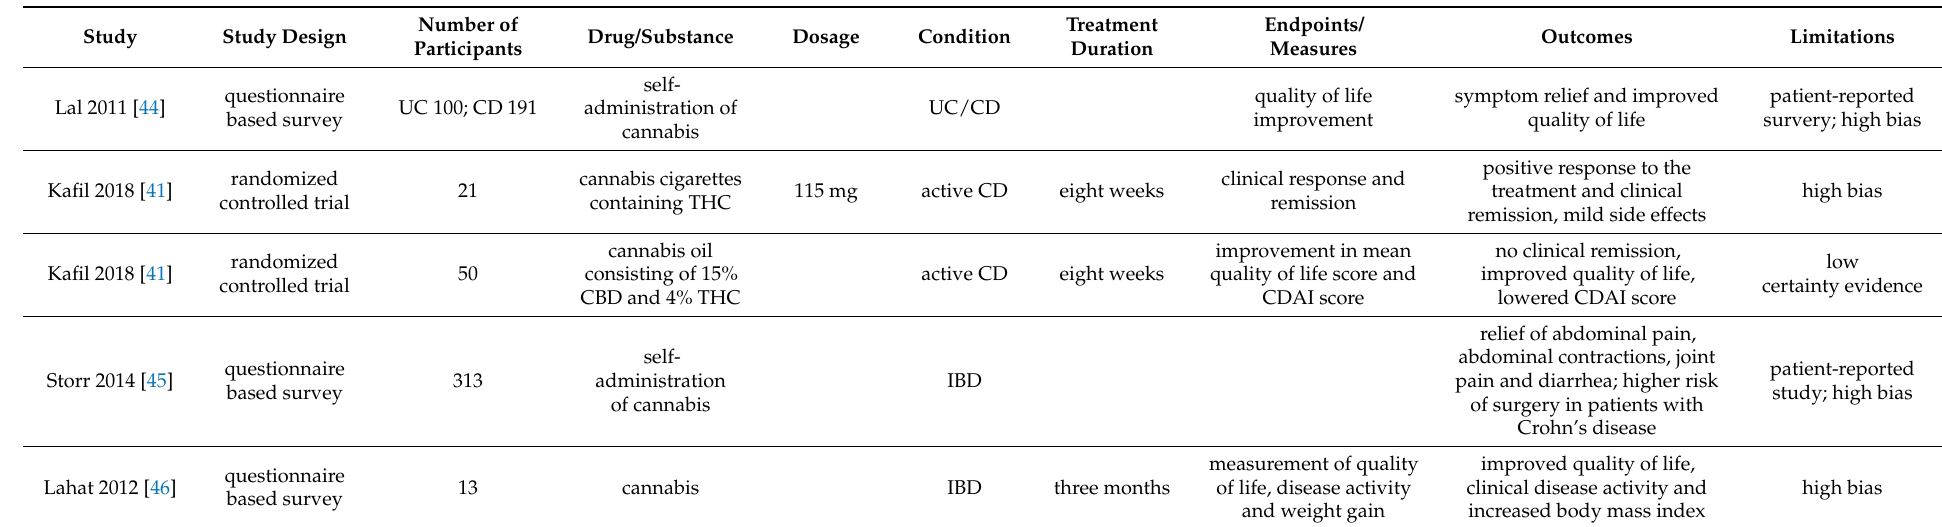
Table 2. Clinical effects of action in the gastrointestinal